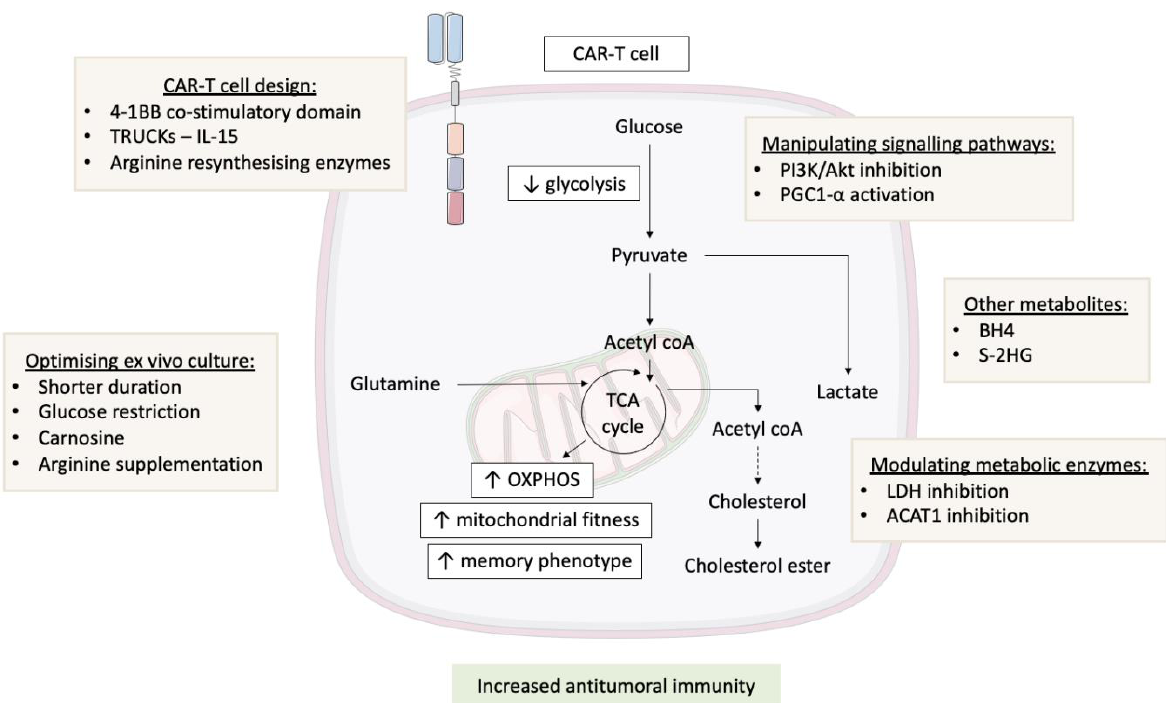
Figure 2. Metabolic optimisation of CAR-T cells. Various strategies are currently being investigated to enhance the metabolic program of CAR-T cells and overcome the metabolic hostility of the TME. This includes improving CAR-T cell design, optimising ex vivo culture conditions, manipulating signalling pathways, and modulating various metabolic enzymes. These strategies increase OXPHOS levels and mitochondrial fitness in CAR-T cells leading to an enhanced central memory T cell compartment, resulting in a fitter CAR-T cell product with improved anti-tumoural immunity. ACAT1, cholesterol acyltransferase 1; BH4, tetrahydrobiopterin; CAR-T cell, chimeric antigen receptor T cell; LDH, lactate dehydrogenase; OXPHOS, oxidative phosphorylation; PGC1- α , PPAR-gamma coactivator 1- α ; S-2HG, S-2-hydroxygluterate; TCA cycle, tricarboxylic acid cycle; TME, tumour microenvironment; and TRUCKs, T-cells redirected for unrestricted cytokine-mediated killing.